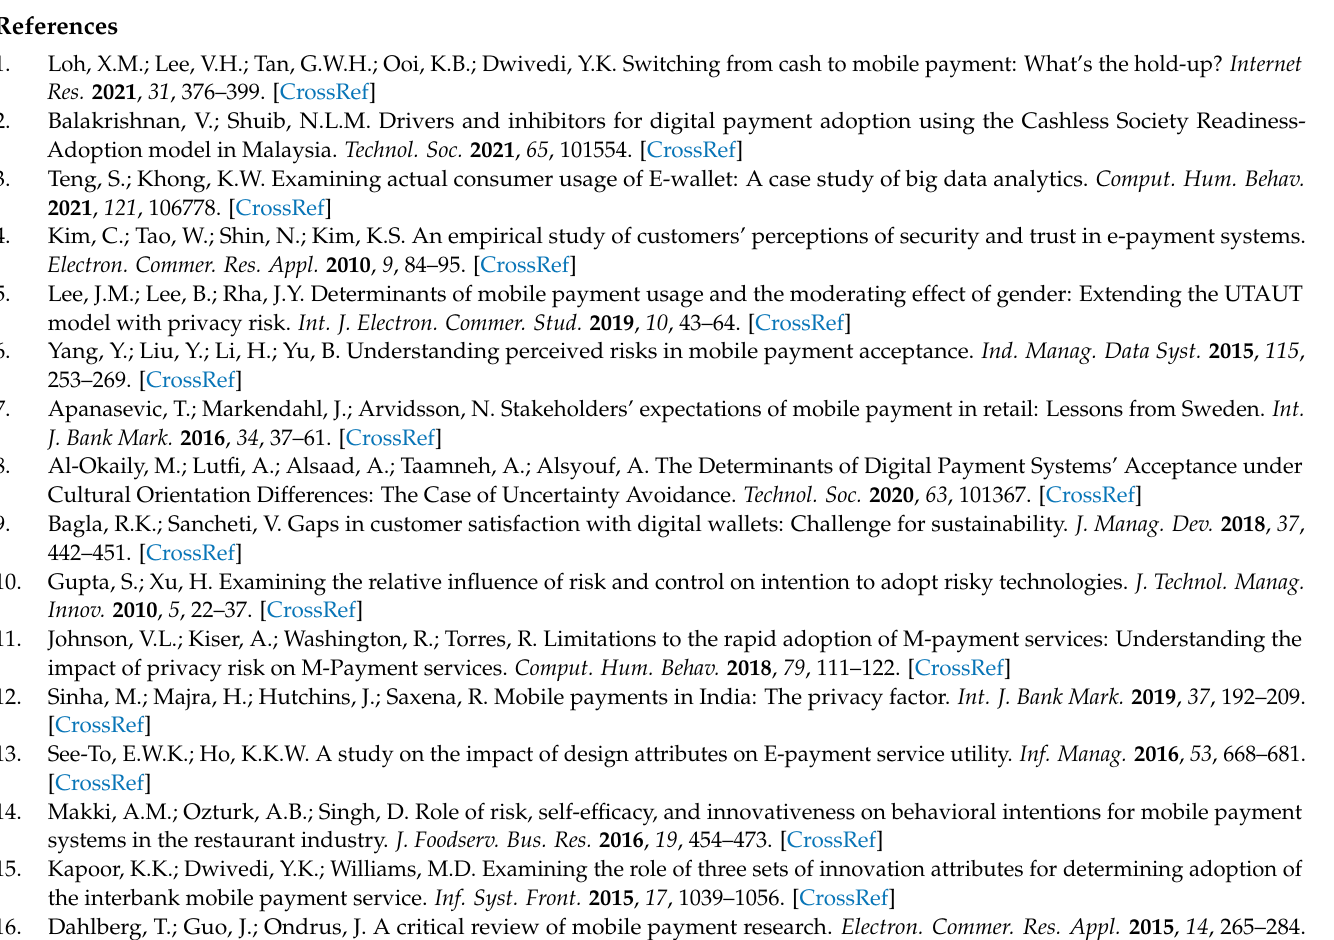
Figure A3. The perceived ease of use factors model of electronic payment.